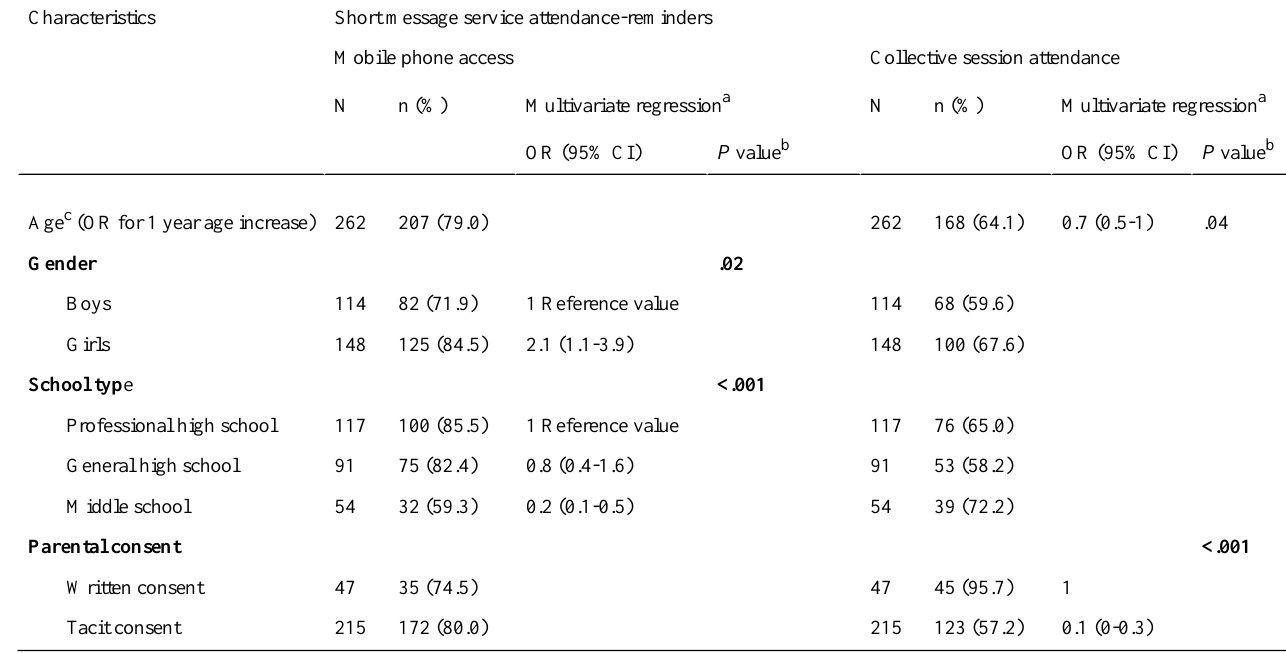
Table 3. Multivariate regression models for access to a mobile phone and participation in collective